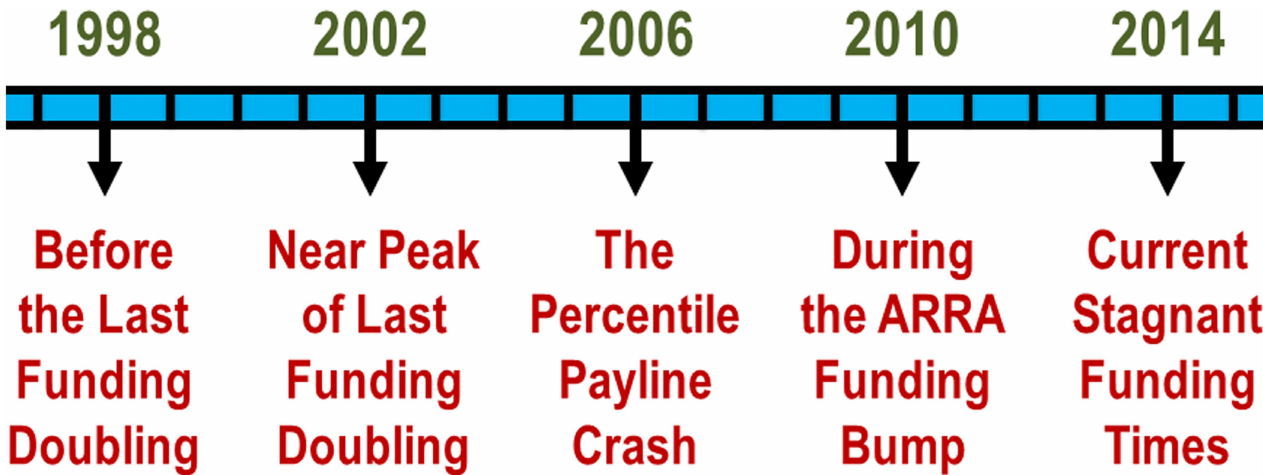
Fig 3. Analysis Timeline. Timeline of fundingand paylineevents duringanalysisproject